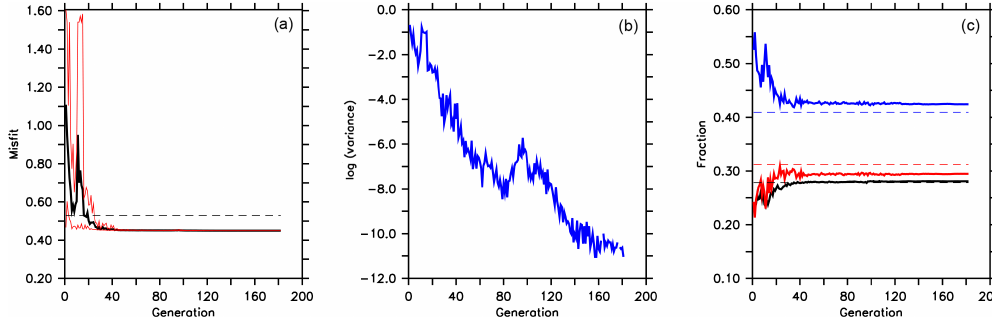
Figure 13. As Fig. 10, but for optimization OBS-NARR. The optimization finished at generation 182.